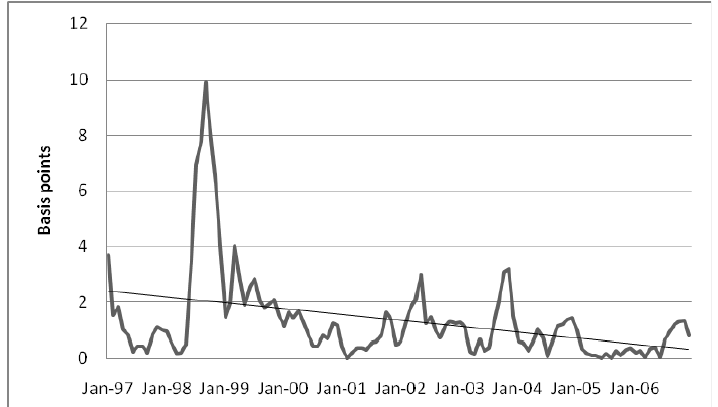
Source: Author’s calculations, based on market data (see Appendix) FIGURE 2: JIBAR 6-month-ahead forecast errors (absolute value, in basis points), 1997-2006